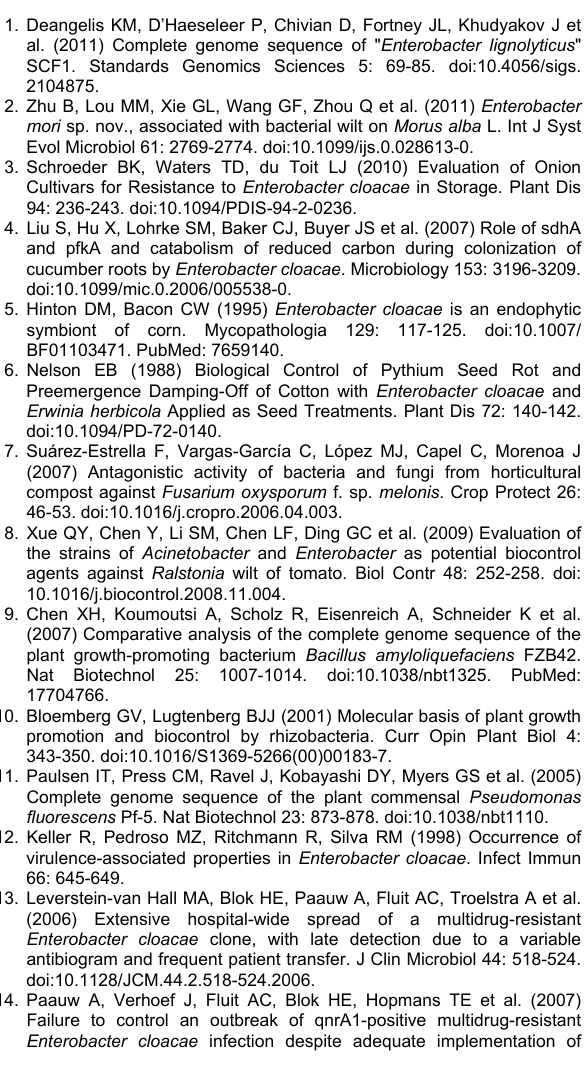
Table S2. resistance, multidrug resistance and multidrug efflux systems in Enterobacter . Table S3. Table shows antagonistic activities of E. cloacae subsp. cloacae ENHKU01 against plant pathogenic fungal